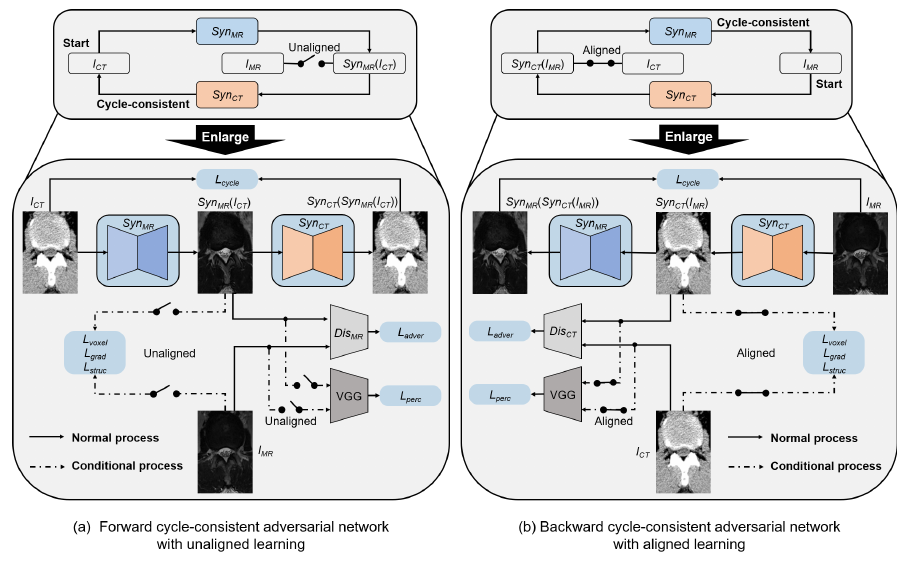
Figure 2. Diagram of the proposed dual cycle-consistent adversarial network (DC 2 Anet). DC 2 Anet consists of a forward cycle-consistent and a backward cycle-consistent network. ( a ) The forward cycle-consistent adversarial network with unaligned learning. ( b ) The backward cycle-consistent adversarial network with aligned